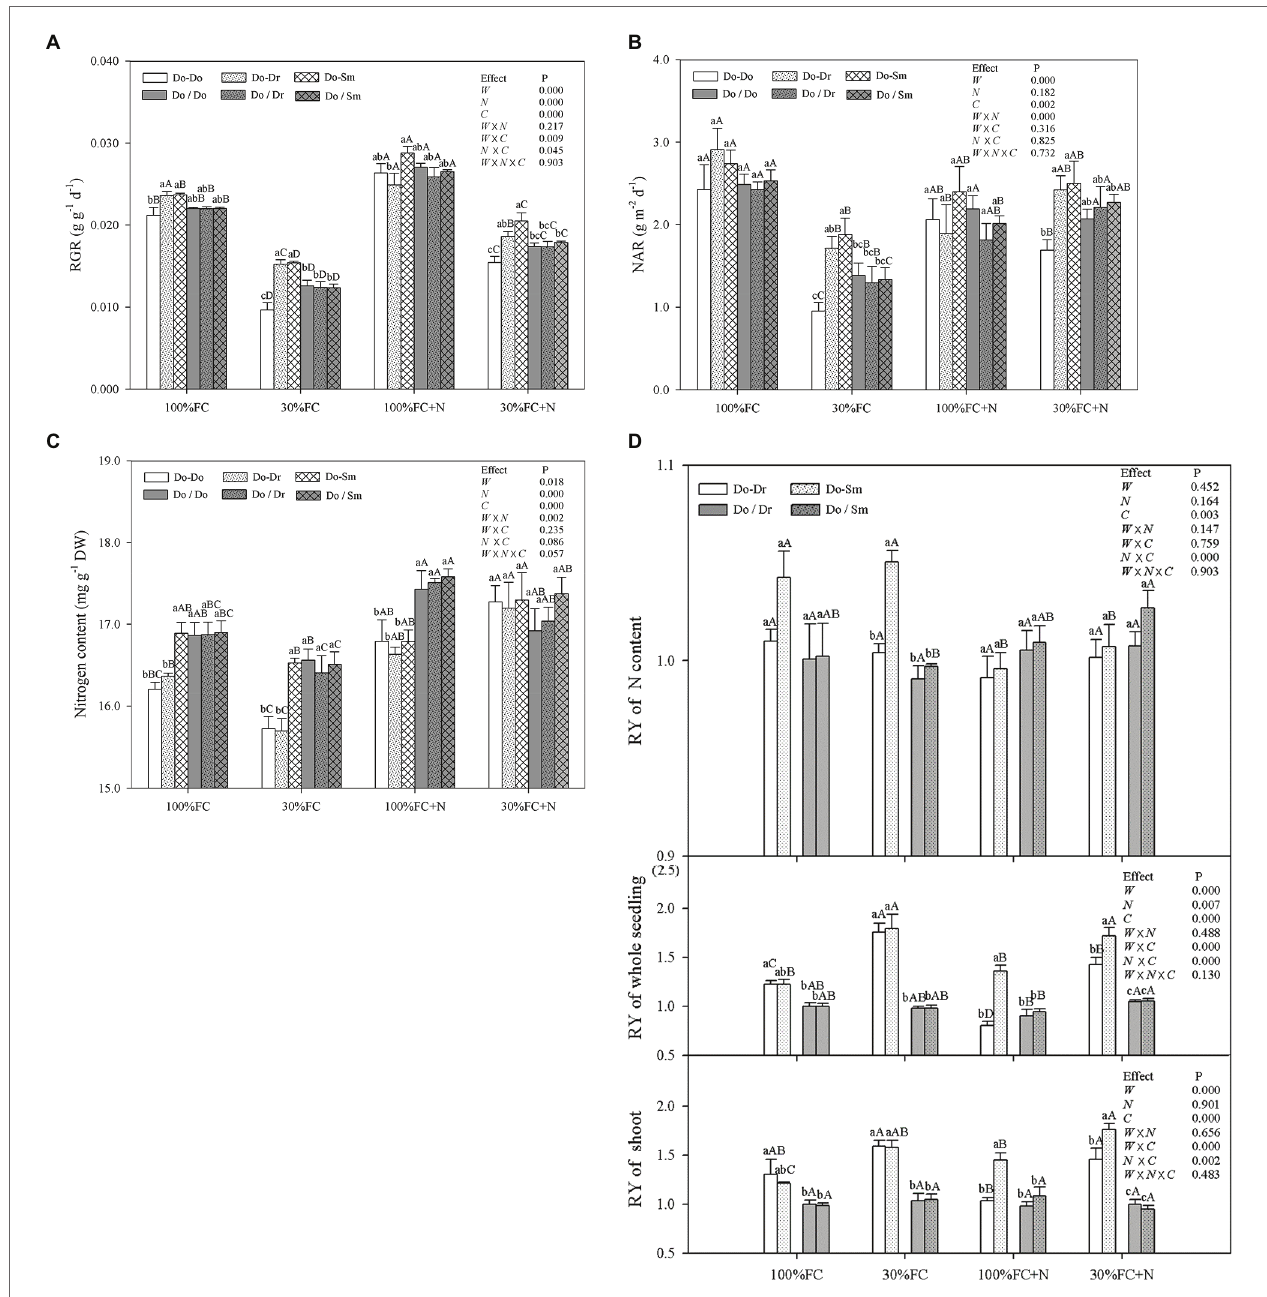
FIGURE 7 | Effects of water, N fertilization levels on RGR (A) , NAR (B) , leaf N content (C) of D. odorifera , and RY of the shoot, whole plantlet, and leaf N content (D) in different species competition models. Different lowercases in each graph indicate significant difference among different competitive models (competition between D. odorifera and various N-fixing niche neighbors) under the same water and N application according to Duncan’s tests ( p < 0.05). Different uppercases in each graph indicate significant difference among different water and N fertilization application in the same competitive models according to Duncan’s tests. For abbreviations explanation of treatments (species competition models, water, and N fertilization), data description, and statistics are the same as shown in Figure 5